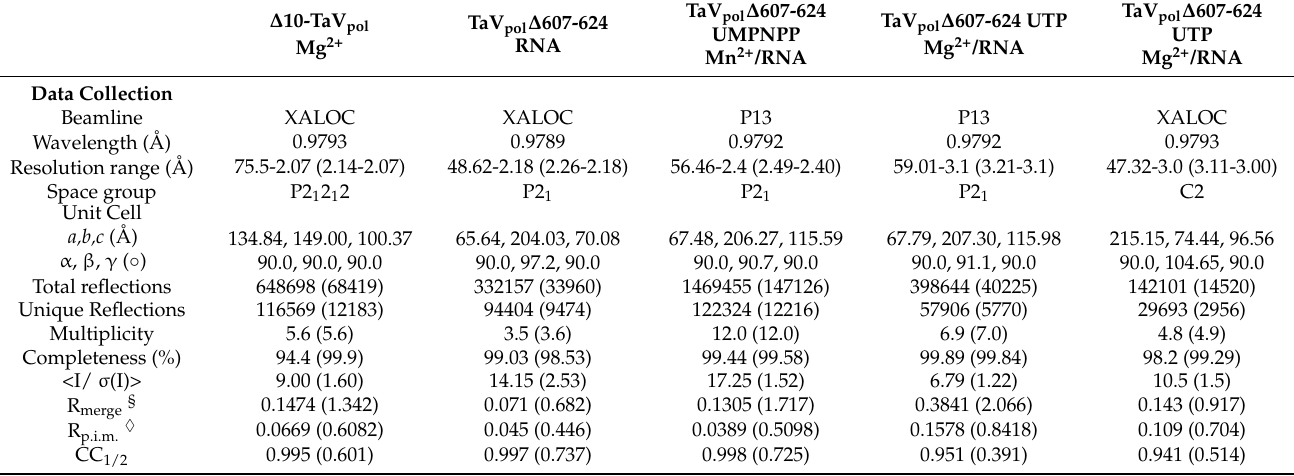
Table 1. Summary of the X-ray data collection and model refinement